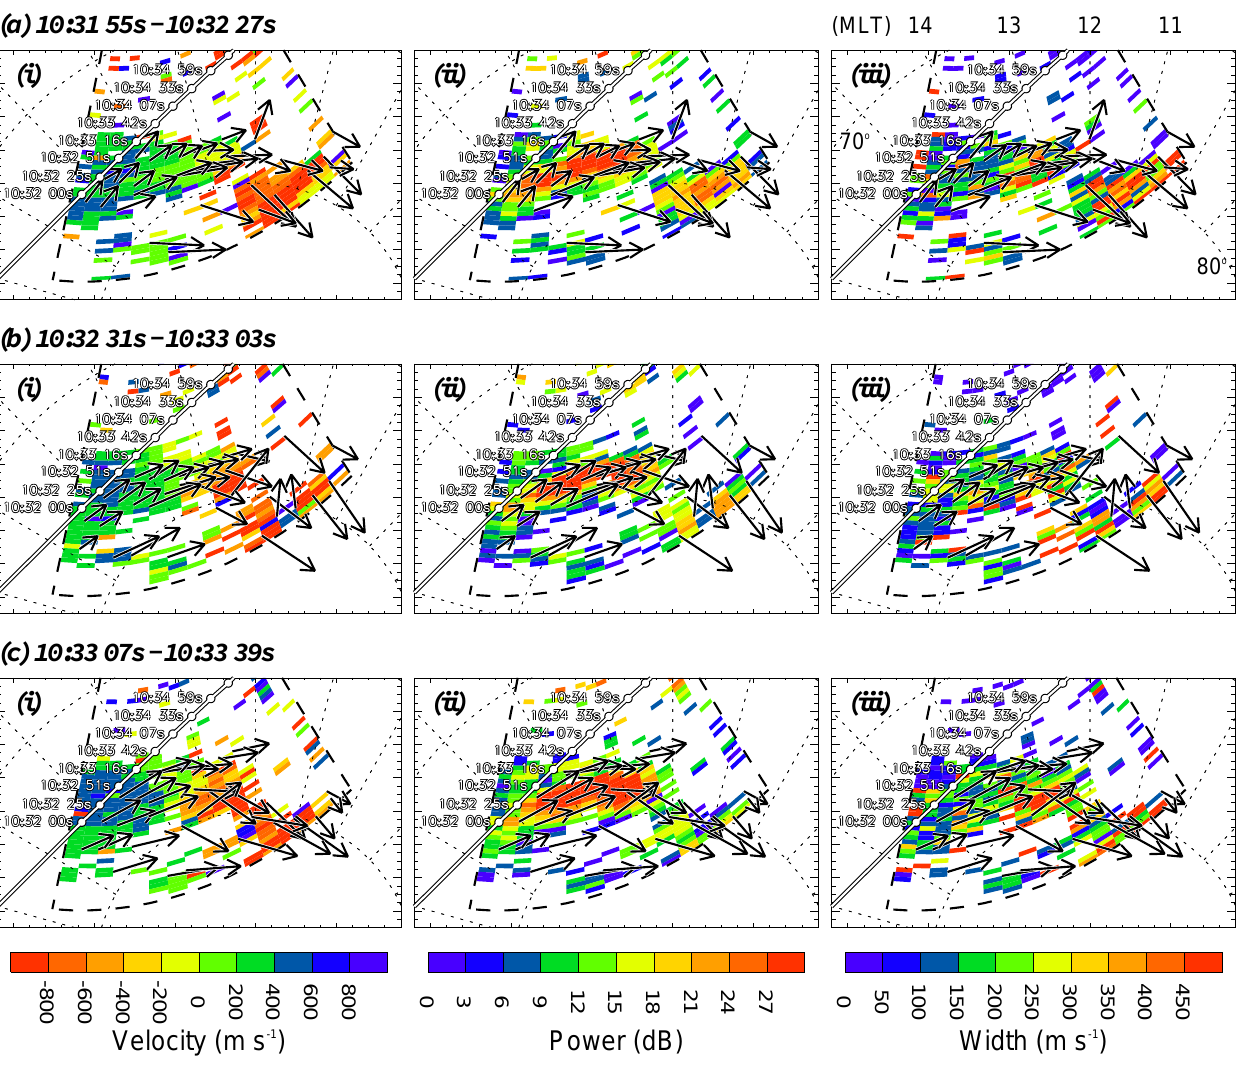
Fig. 5. CUTLASS Hankasalmi scans for three 32 s scans centred on the DMSP overpass. Beamswung velocity vector estimates and the spacecraft track footprint are overlaid. (a) 1031:55–1032:27 UT (i) line-of-sight velocity (ii) backscattered power (iii) spectral width;